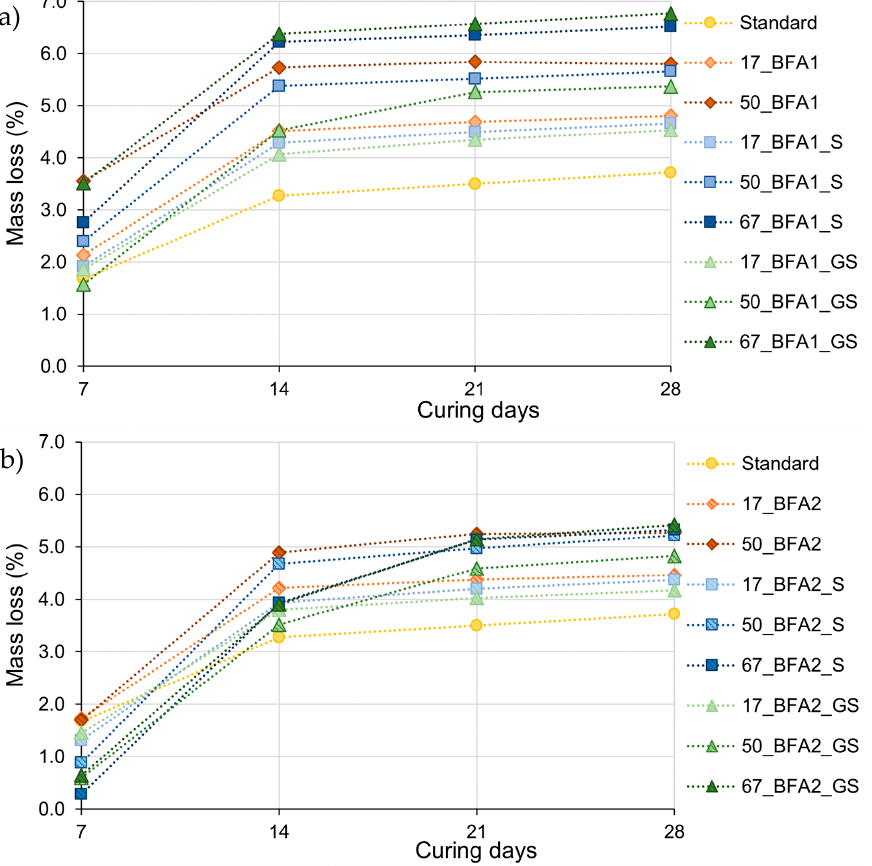
Figure 3. Mass loss upon curing for the compositions prepared with: ( a ) BFA1 powders, and ( b ) BFA2 powders.